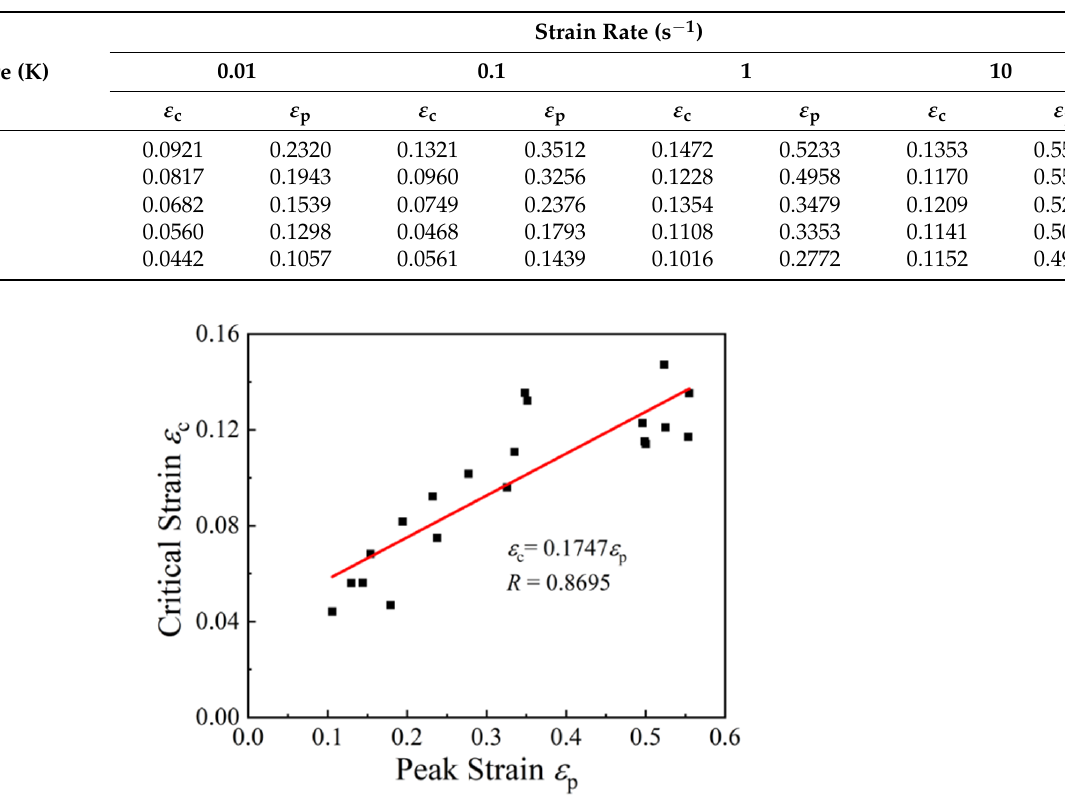
Table 2. Values of ε c and ε p under temperatures of 1123–1483 K and strain rates of 0.01–10 s − 1 .